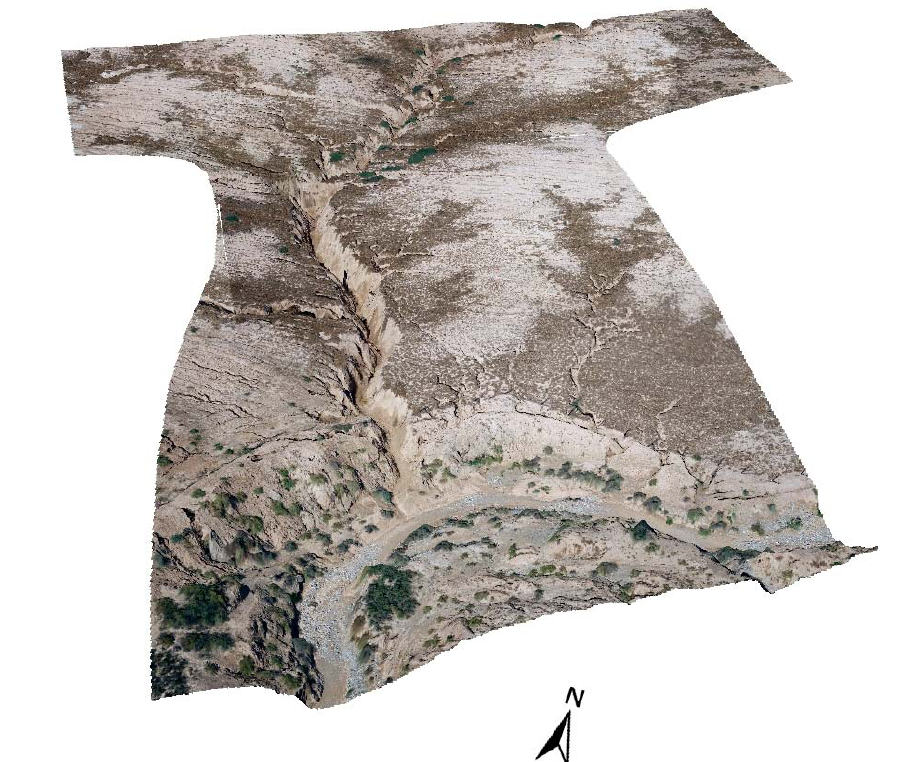
Figure 12. Ortho-image mosaic of study site